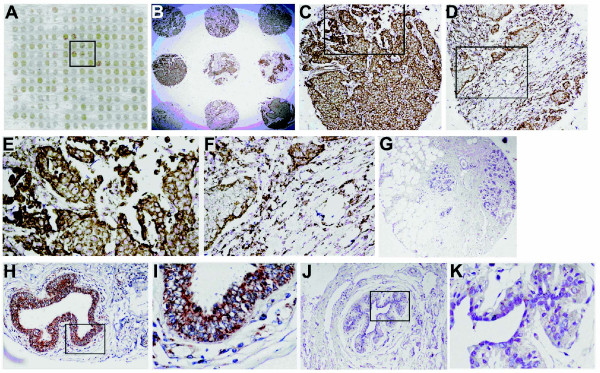
IHC analysis of ATP synthase α-subunit expression in breast cancer tissue, atypical breast hyperplasia and normal breast tissue. The breast cancer tissue microarrays were probed with the anti-ATP synthase α-subunit mAb (brown), and hematoxylin was used for counterstaining (blue). A, A representative arrangement of "spots" on the breast cancer tissue microarray slide. B, Low-power magnification shows strong and moderate immunoreactivity samples on the microarray slide (40×). C and D, Examples of a strong and a moderate immunostaining, respectively, of ATP synthase α-subunit in epithelial cells of breast infiltrating duct carcinoma samples at increased magnification (200×). E and F, A high-power view suggests immunoreactivity of the ATP synthase α-subunit antibody in the cellular membrane and granular cytoplasmic distribution (400×). G, Absent staining in normal breast tissue. Original magnification (200×). H, I, J and K, Atypical breast hyperplasia exhibiting a less intense (H and I) or absent immunostaining (J and K) at low-power (H and J, 200×) and high-power (I and K, 400×) magnifications.